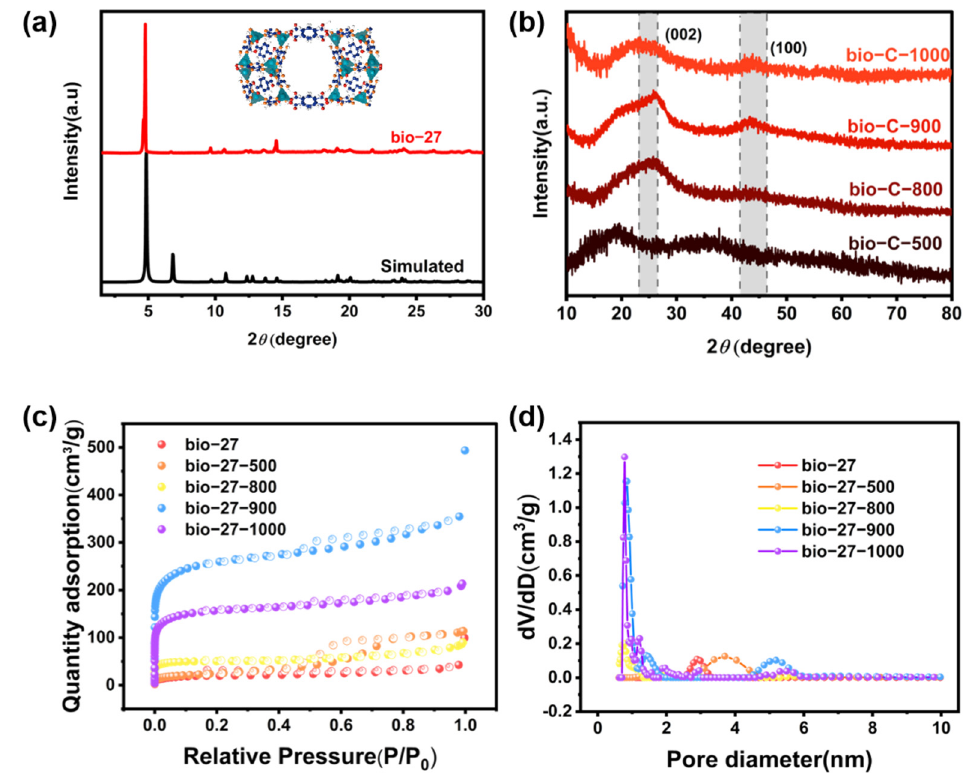
Figure 2. ( a ) PXRD patterns of IISERP − MOF − 27 and its ( b ) derived carbon materials, which are py- rolyzed at temperatures ranging from 500 °C to 1000 °C. ( c ) The nitrogen adsorption and desorption isotherms of bio − 27 and bio − C − T. ( d ) The pore size distribution of the as-prepared samples of bio − 27 and bio − C − T (T = 500~1000 °C).